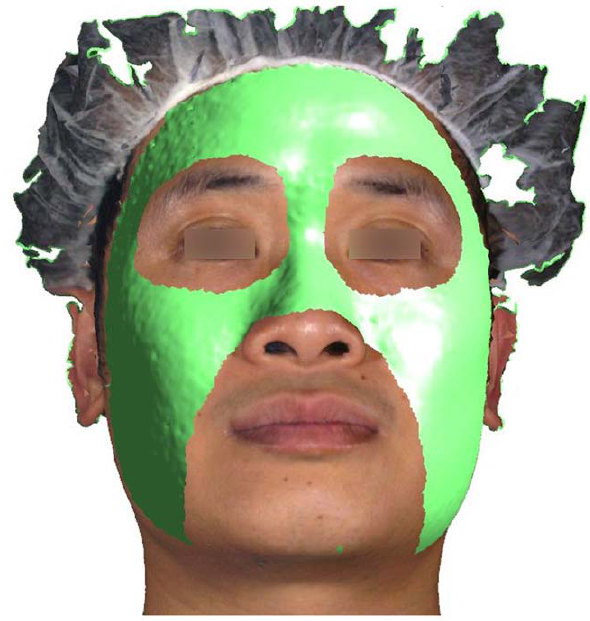
Figure 4. The region used as a reference during registration.